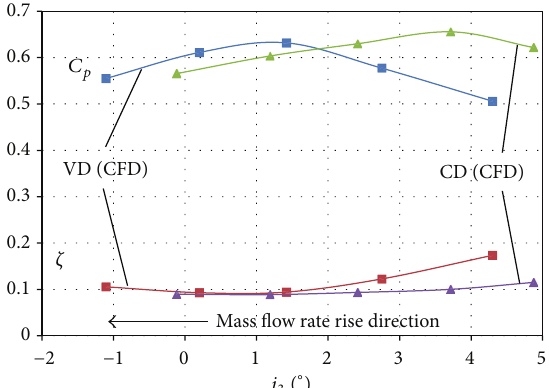
Figure 7: Nondimensional characteristics of designed CD and base VD.